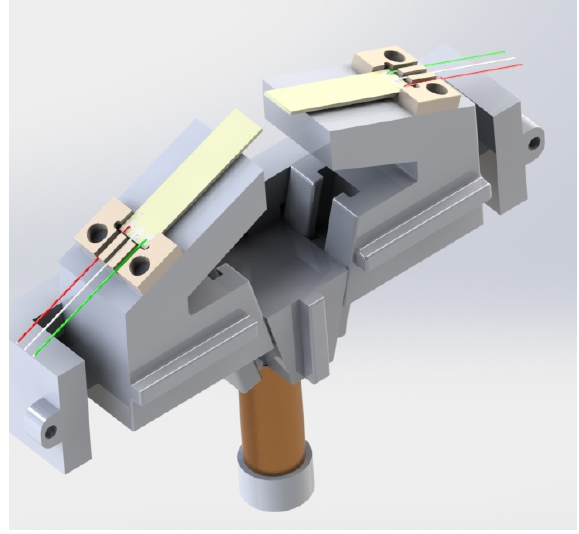
Figure 2. Gripper side view θ 1